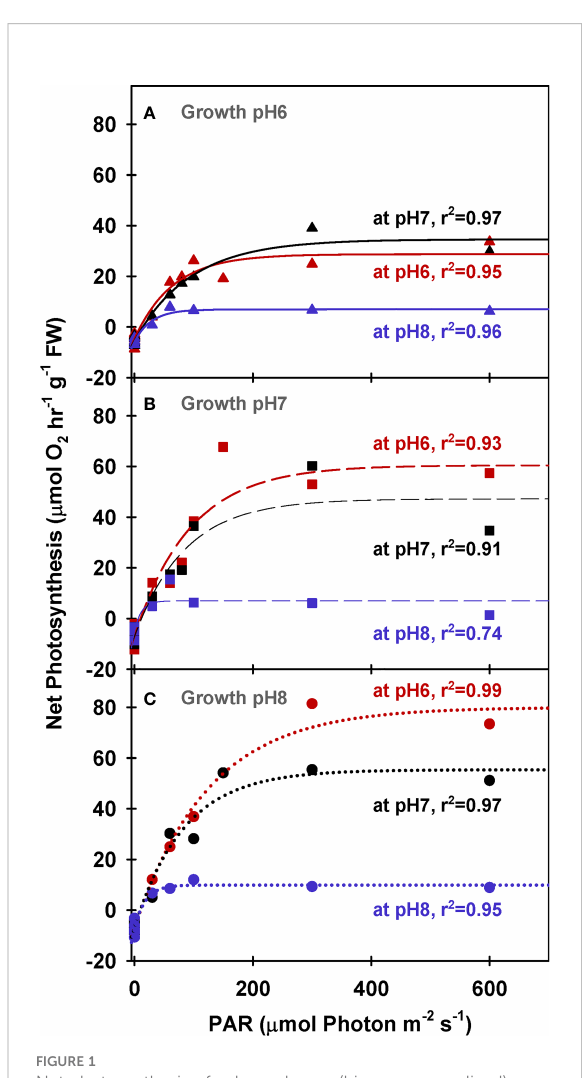
FIGURE 1 Net photosynthesis of eelgrass leaves (biomass normalized) as a function of irradiance. O 2 production rates were measured at different pH levels (red: pH6, black: pH7 and blue: pH8) using leaves grown at pH6 (2121 µ M CO 2(aq) ) (A) , pH7 (371 µ M CO 2(aq) ) (B) and ambient pH8 (55 µ M CO 2(aq) ) (C) . Curves were fi t using Equation